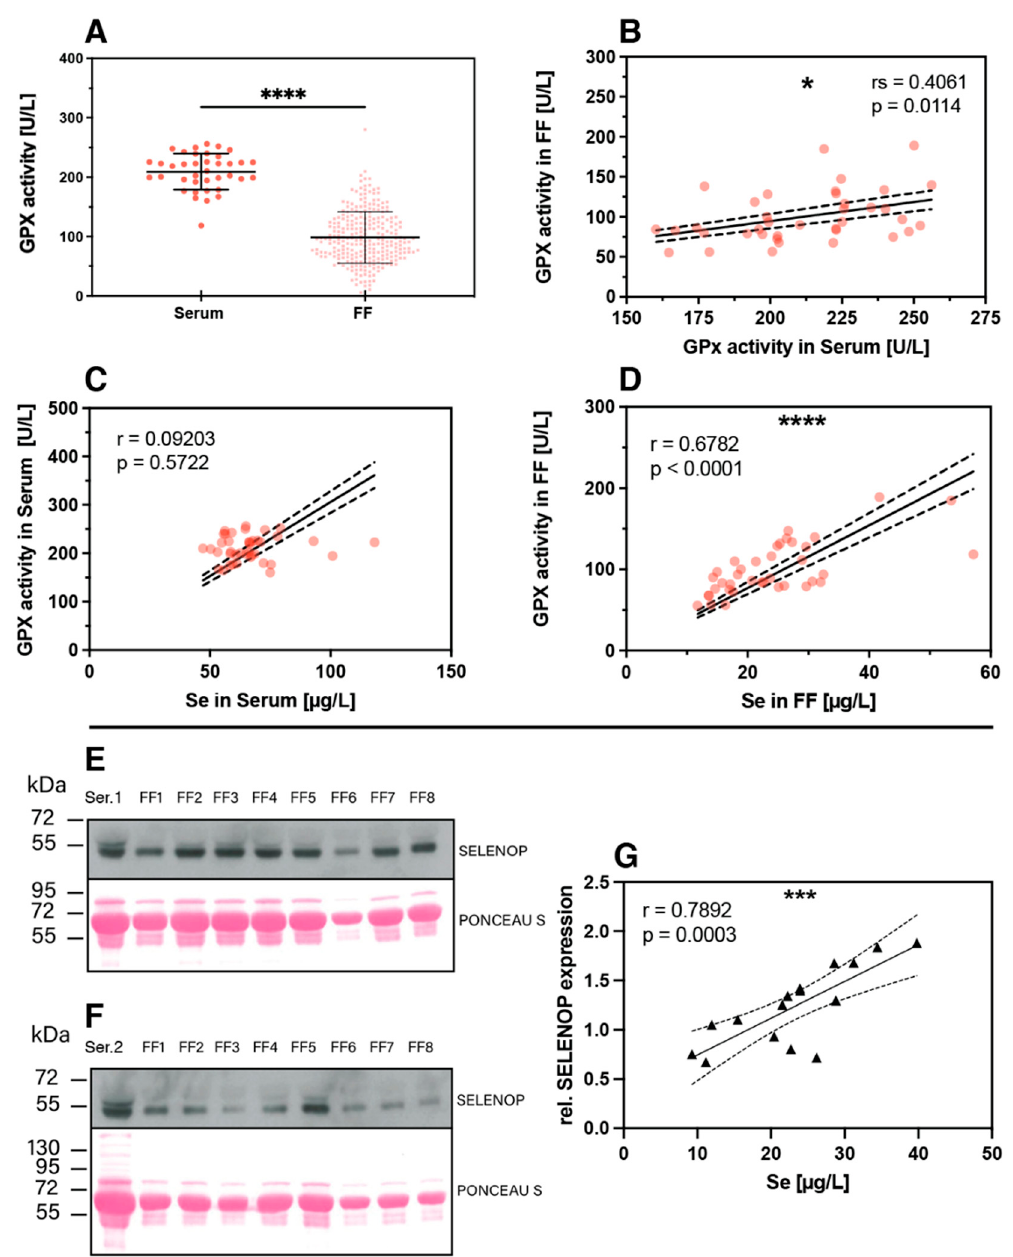
Figure 6. Protein biomarkers of Se status in FF and serum. ( A ) Expression of the extracellular glutathione peroxidase (GPX3) was analyzed in the serum and FF samples and showed lower and very variable enzymatic activity in FF. Analysis of significance was conducted with the mean FF GPX3 activity from the same woman with the corresponding serum by paired t -test. ( B ) The GPX3 activities in serum and corresponding FF samples from the same woman showed a linear and positive correlation. ( C ) The correlation between serum GPX3 activity and total serum Se was poor, whereas ( D ) GPX3 activity and total Se concentration in the FF correlated strongly and linearly. ( E , F ) Western blot analysis indicates SELENOP expression in the FF samples at the same size and band pattern at 50–55 kDa as in the corresponding serum sample; analysis was conducted in the sample sets of one subject selected from the group of subfertile ( E ) and PCOS ( F ) women each. Ponceau S staining illustrates the loading of the lanes for improved comparison of signal strengths. ( G ) A positive linear correlation is observed for SELENOP and total Se in the FF samples. Statistical significance is indicated by * p < 0.05, *** p < 0.001 and **** p <